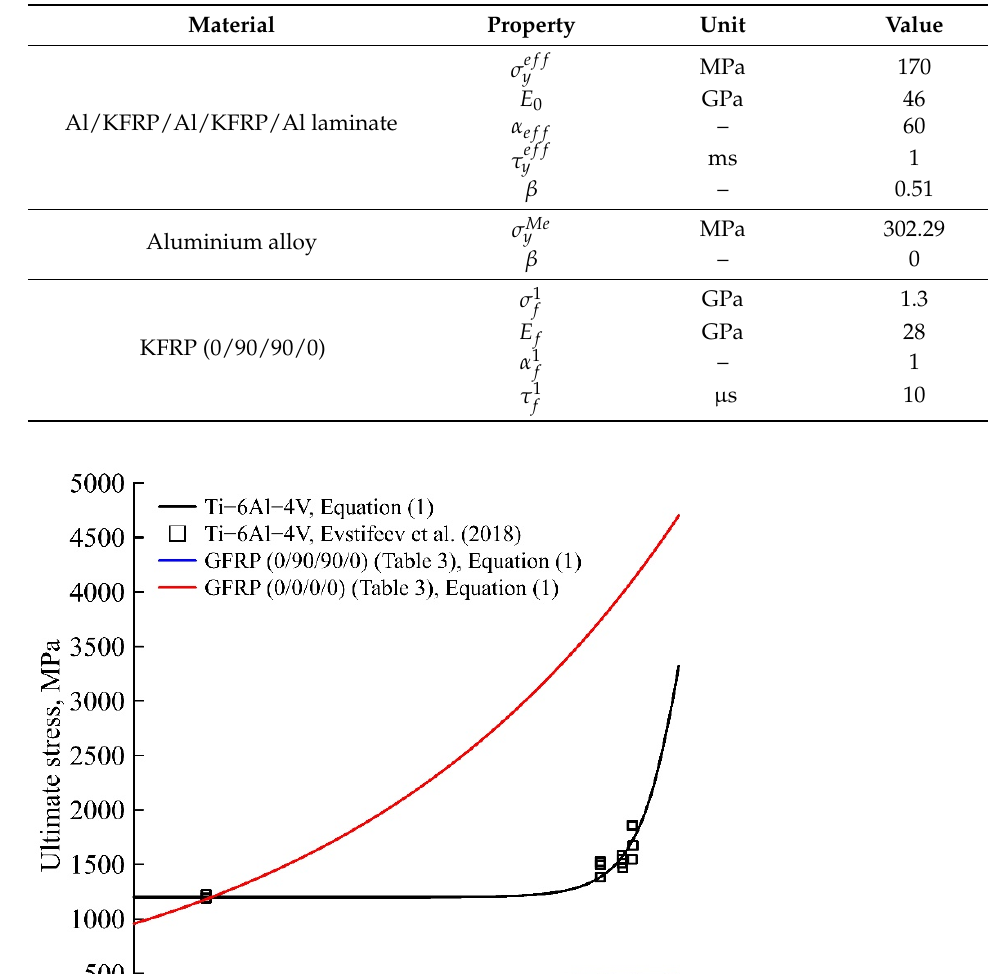
Table 6. Parameters of the model and materials [46] for the calculated deformation curves of the Al/KFRP/Al/KFRP/Al composite in Figure 4b.